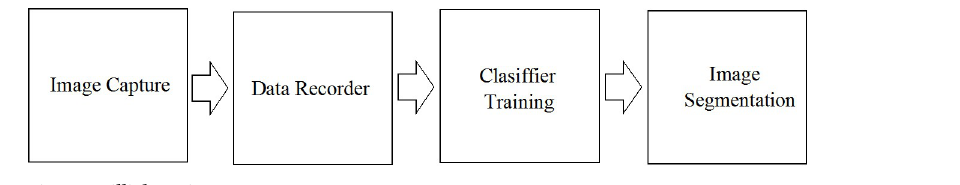
Fig 3. Bacilli detection process.